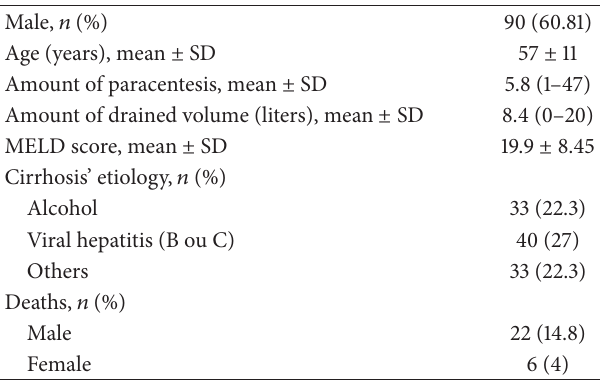
Table 1: Demographic and clinical characteristics of 148 patients who underwent paracentesis